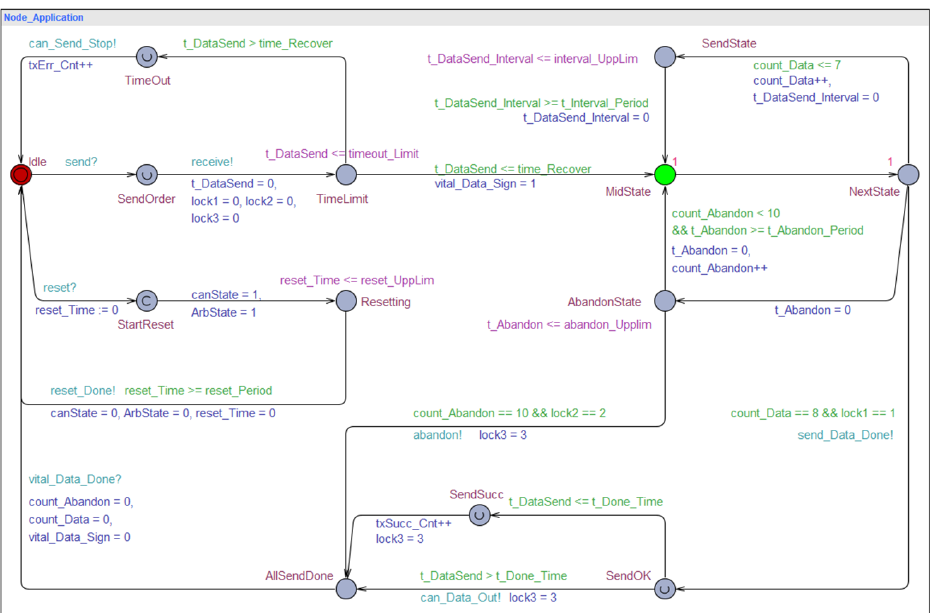
Figure 7. TA of the CAN bus application layer: Node_Application.